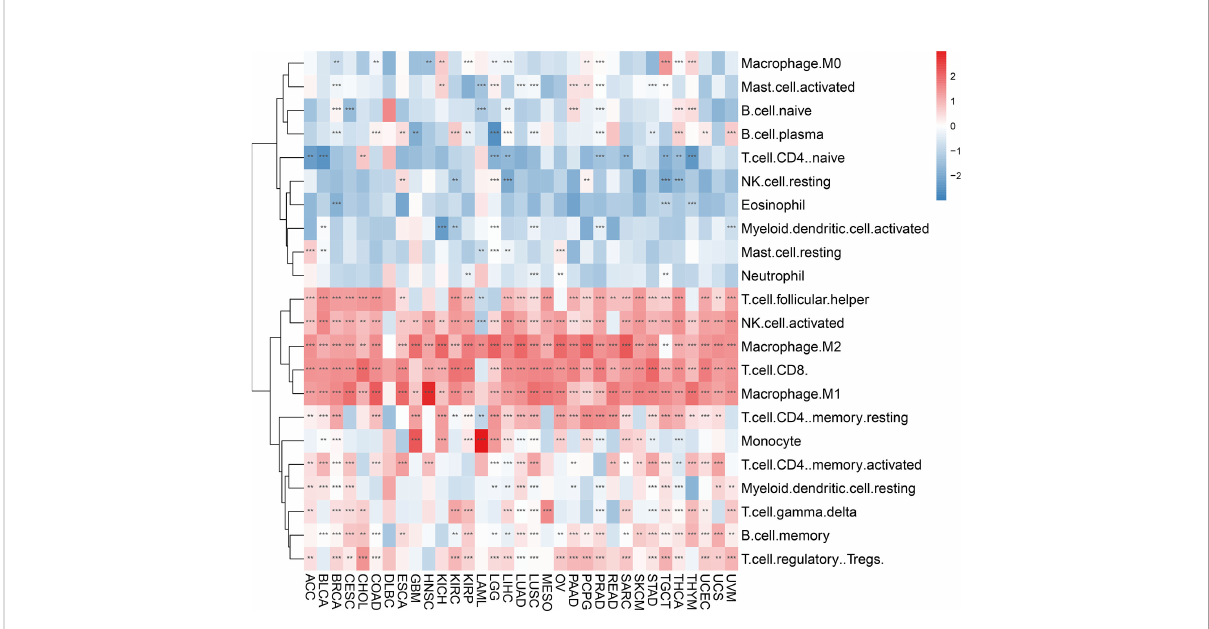
FIGURE 9 Immune cell in fi ltration analyses. Relevance of the AIM2 in fl ammasomes scores to tumor-in fi ltrating immune cells in 33 tumors. The red color indicates a positive correlation and the blue color indicates a negative correlation. **p < 0.01, and ***p < 0.001. (Spearman ’ s correlation test).